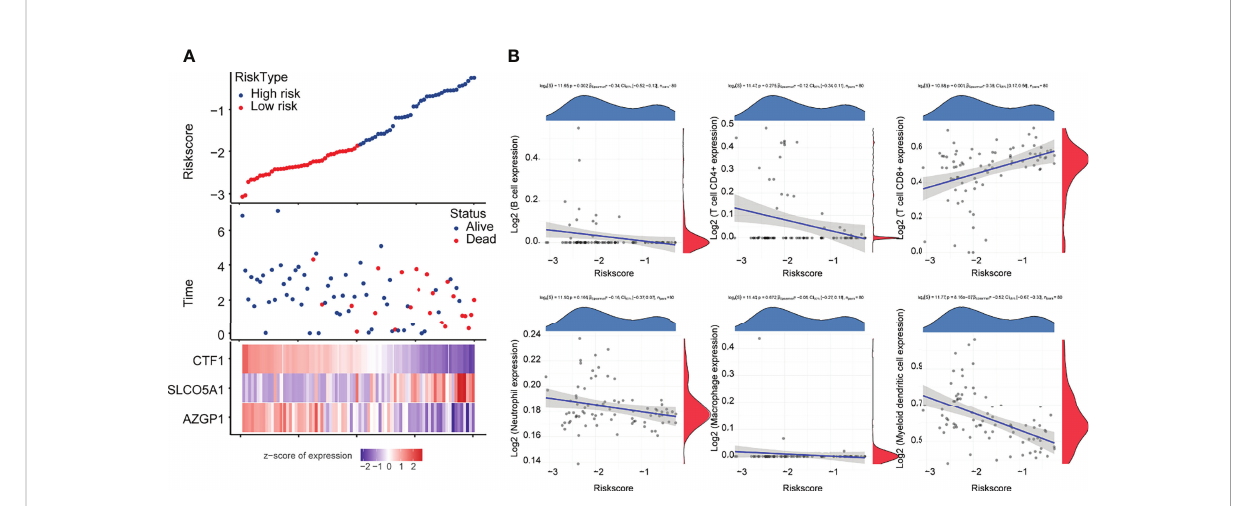
FIGURE 4 Correlation analysis of the prognostic signature model with tumor immune cell in fi ltration (A) Survival status and duration of patients with UM; (B) letters A – G represent B cells, CD4+ T cells, CD8+ T cells, neutrophils, macrophages, myeloid dendritic cells, and uncharacterized cells, respectively. The horizontal coordinates in the fi gure represent the model score distribution, whereas the vertical coordinates are the immune score distribution. The density curves on the right side represent the immune score distribution trends. The upper side density curve is the trend of distribution of one gene or model score. The uppermost value represents the correlation p -value, correlation coef fi cient, and correlation calculation method, with p < 0.05 considered as statistically signi fi